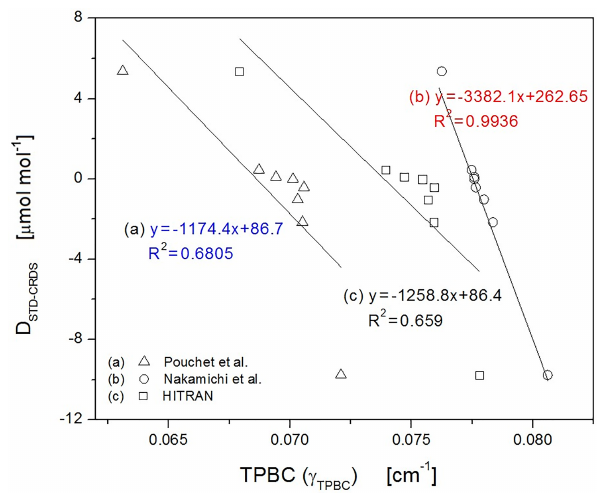
Figure 4. Total pressure broadening coefficient vs. difference be- tween CRDS-measured and assigned CO 2 levels of standard gas mixtures. Due to the lack of γ Ar , correlations (a) and (c) exhibit poor